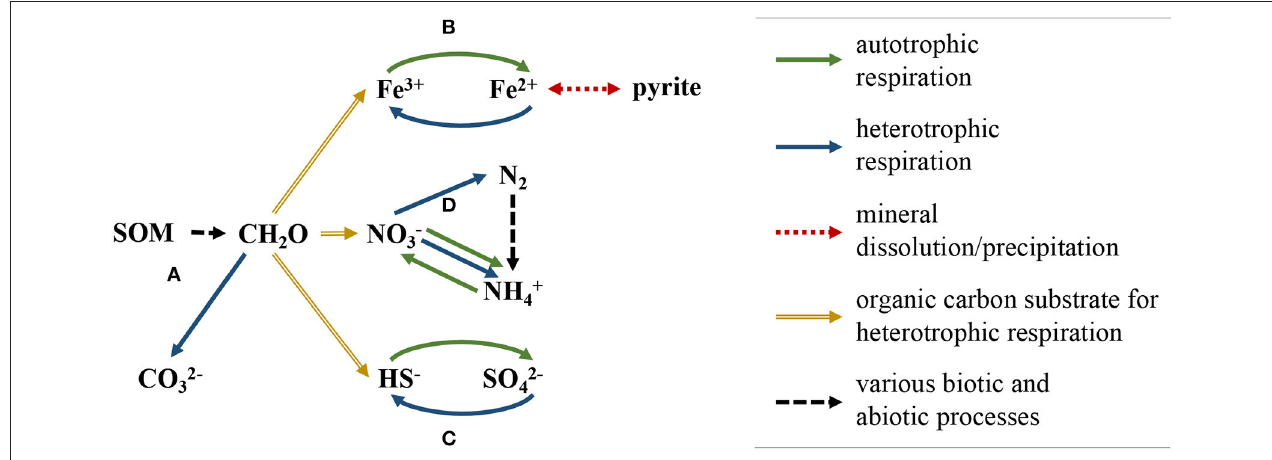
FIGURE 6 | Schematic of biogeochemical reaction network implemented in model simulations. SOM degrades to CH 2 O, which then participates in the following reaction pathways; (A) organic matter oxidation, (B) Fe(III)/Fe(II) reduction-oxidation, which affects the rate of pyrite dissolution/precipitation, (C) sulfide/sulfate reduction-oxidation, and (D) nitrogen reduction-oxidation, which includes nitrogen fixation, nitrification, dissimilatory nitrate reduction to ammonium, and